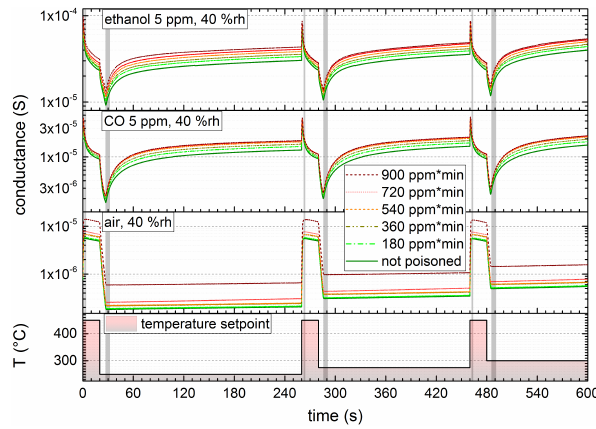
Figure 6. Temperature cycle for robust gas measurement and cor- responding conductance profiles for 5ppm ethanol, 5ppm carbon monoxide and pure air, respectively, all at 40%RH and for differ- ent poisoning states. The six areas shaded in gray with durations of 1s for the three sections at 450 ◦ C and 5s for the three sections at lower temperatures indicate the sections of the cycle from which features (mean value and slope) were extracted for the subsequent